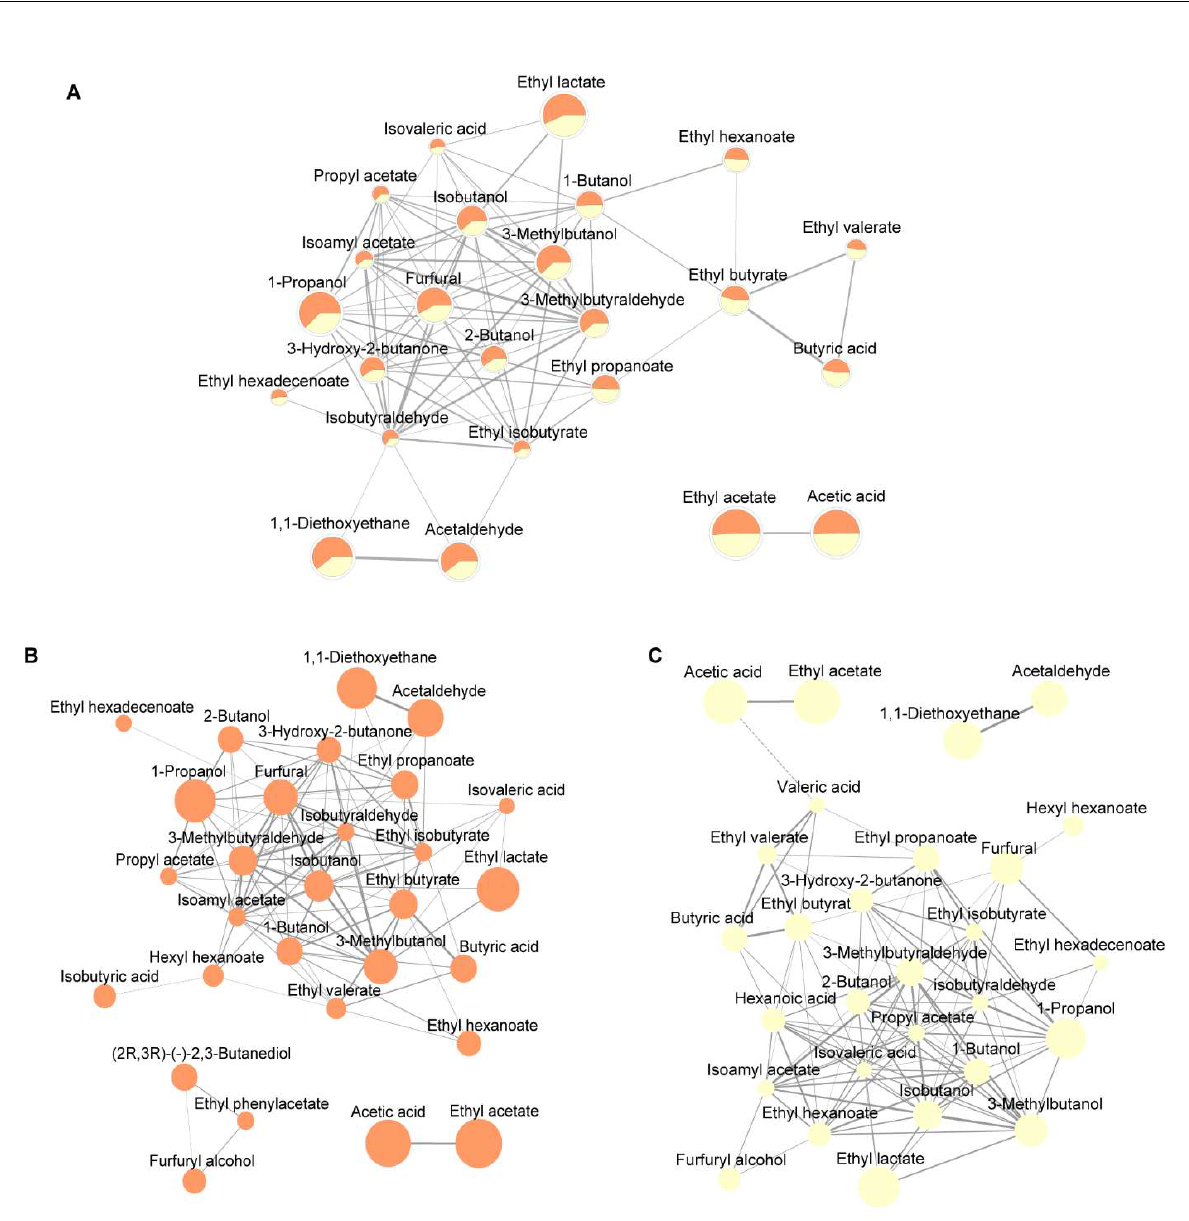
Figure 3. Compound co-abundance correlation network calculated with correlation coefficient of two groups. ( A ) Compound co-abundance correlation network in the total dataset. The pie charts showing the nodes represent the average compound abundance in two groups. The orange pies represent the compound average abundance in the RG group, and the yellow pies represent the compound average abundance in the RP group. ( B ) Compound co-abundance correlation network in the RG group. ( C ) Compound co-abundance correlation network in the RP group. The solid edges represent positive correlations between the compounds, and the dashed edge represents a negative correction between the compounds. The size of the nodes represents the logged average compound abundances in SAB, and the width of the edges represents the correlation coefficient value of two compound abundances; wider edges represent stronger